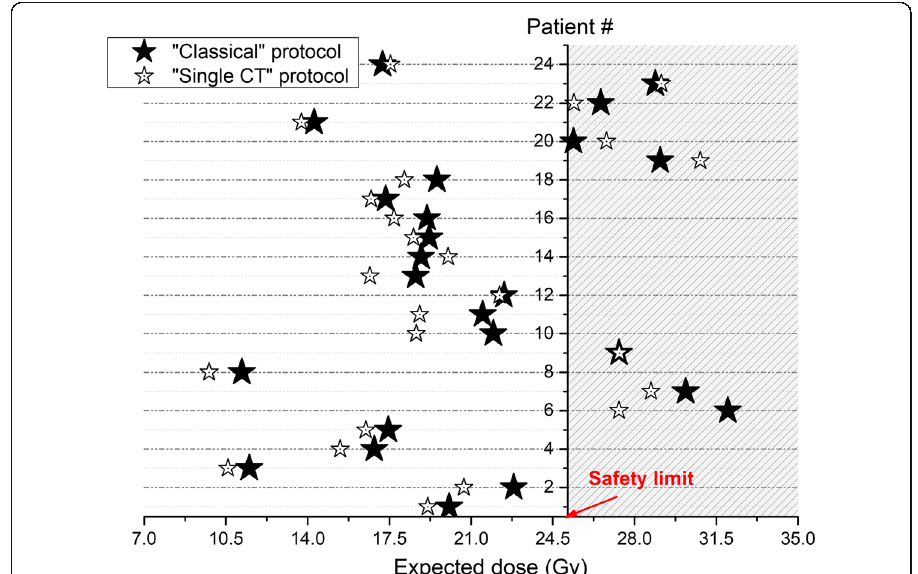
protocol (black stars) or the “ single CT ” protocol (empty stars). Each horizontal line represents a patient, and the dashed region represents the unsafe dose region and interruption of the treatment (patients # 6, 7,